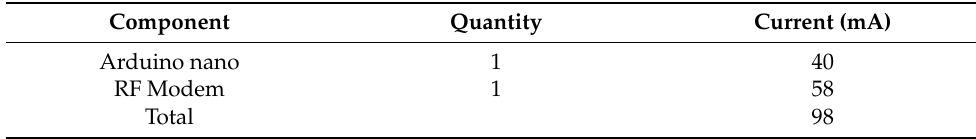
Table 8. Current Consumption Analysis of